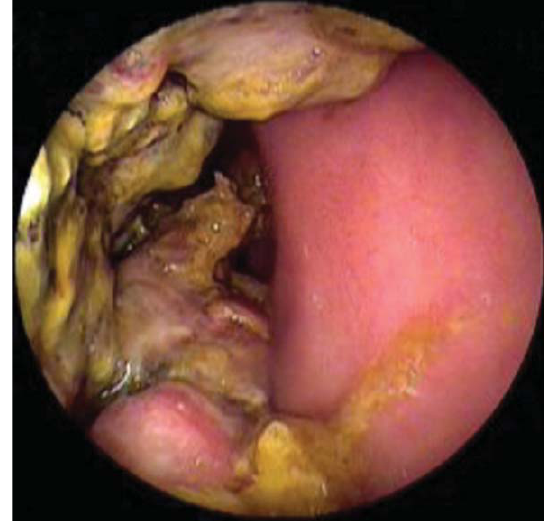
Figure 2. Primary adenocarcinoma of the duodenum